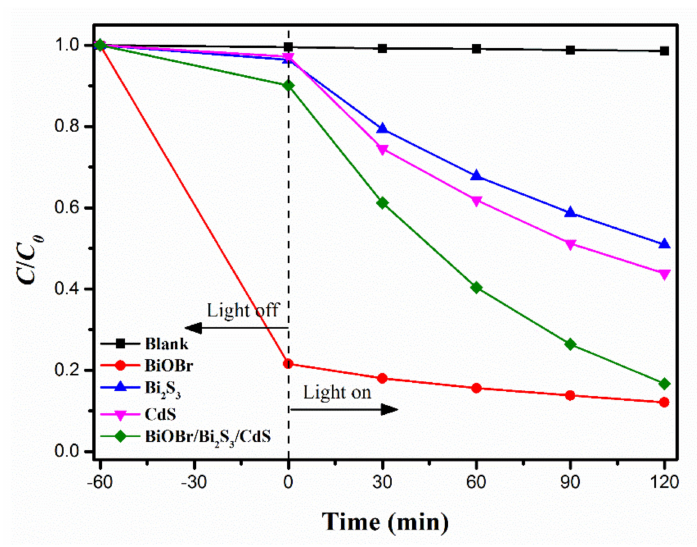
Figure 5. Effect of different catalysts on photocatalytic degradation of MeB.